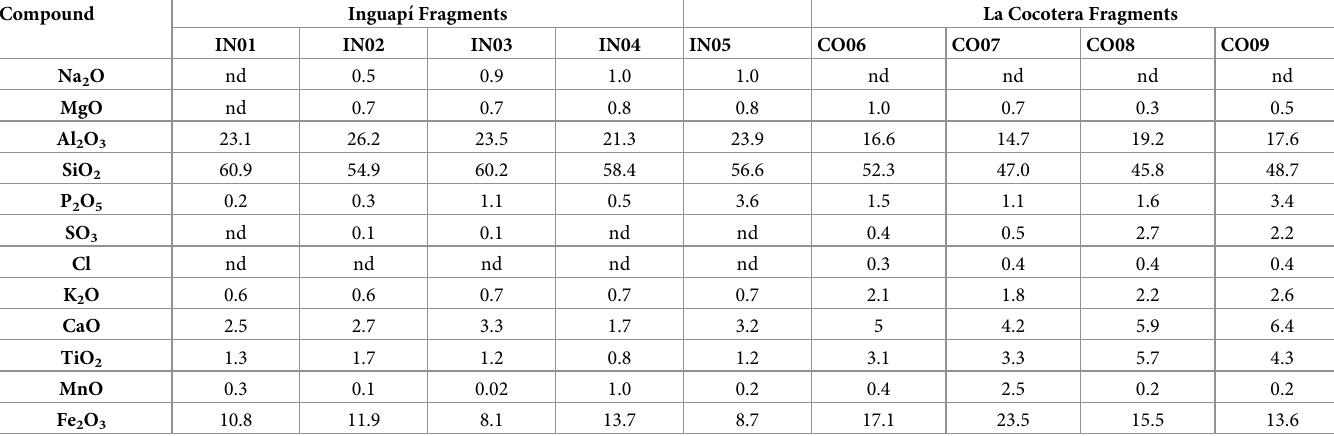
Table 5. Results of the bulk chemical composition obtained by XRF, presented as stoichiometric percentages by weight.